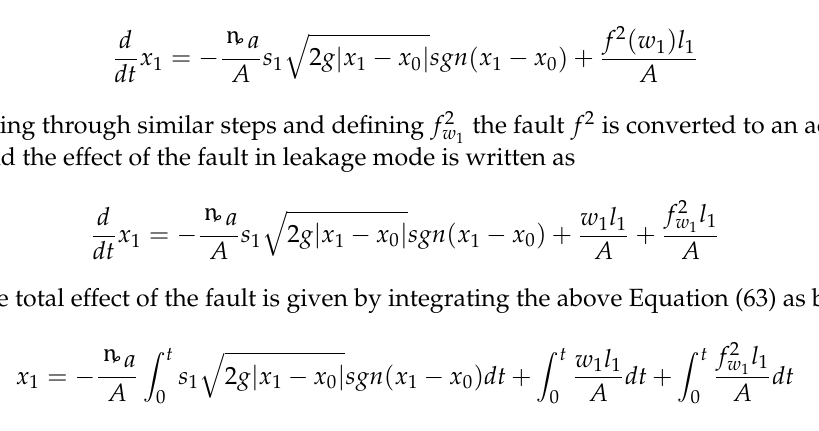
Figure 1. Three-pond hydraulic system.